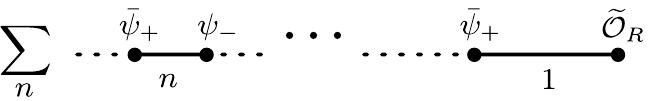
Figure 17 . Inserting the boundary operator e O R ∈ { D 3 ψ − , ψ − , D + ψ + } at the rightmost boundary x 0 would only affect the first ladder that is being condensed. Therefore, verifying (4.37) for the first ladder is